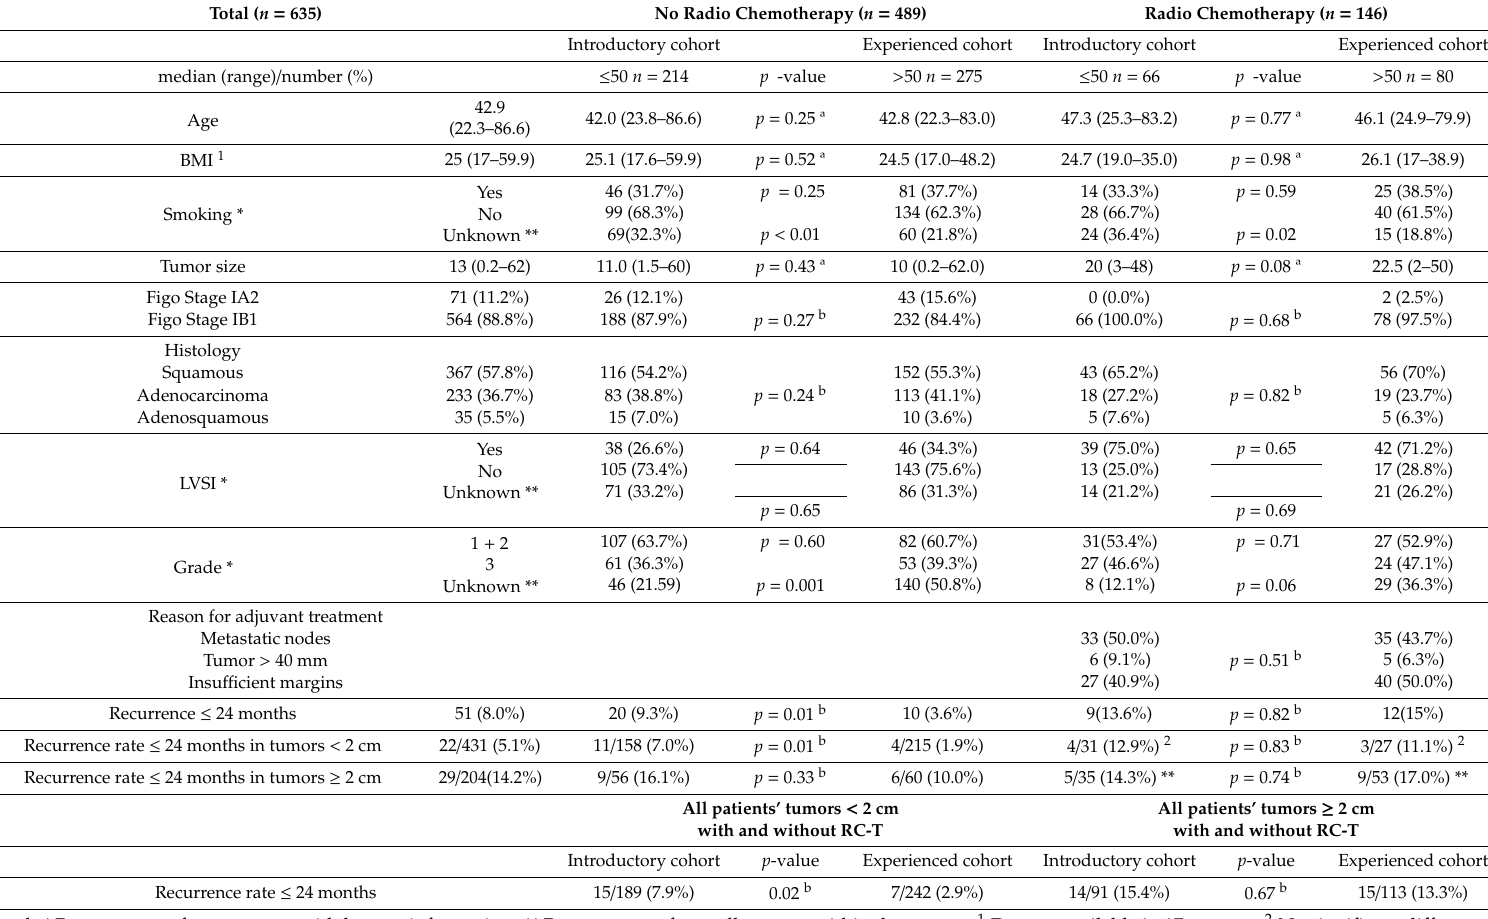
Table 1. Characteristics of 635 patients with stage IA2-IB1 squamous, adenocarcinoma or adenosquamous cervical cancer operated with robotic radical hysterectomy in Sweden between December 2005 and June 2017 with or without postoperative radio chemotherapy. Introductory and experienced cohort refer to the first 50 surgeries per institution compared to all following robotic radical